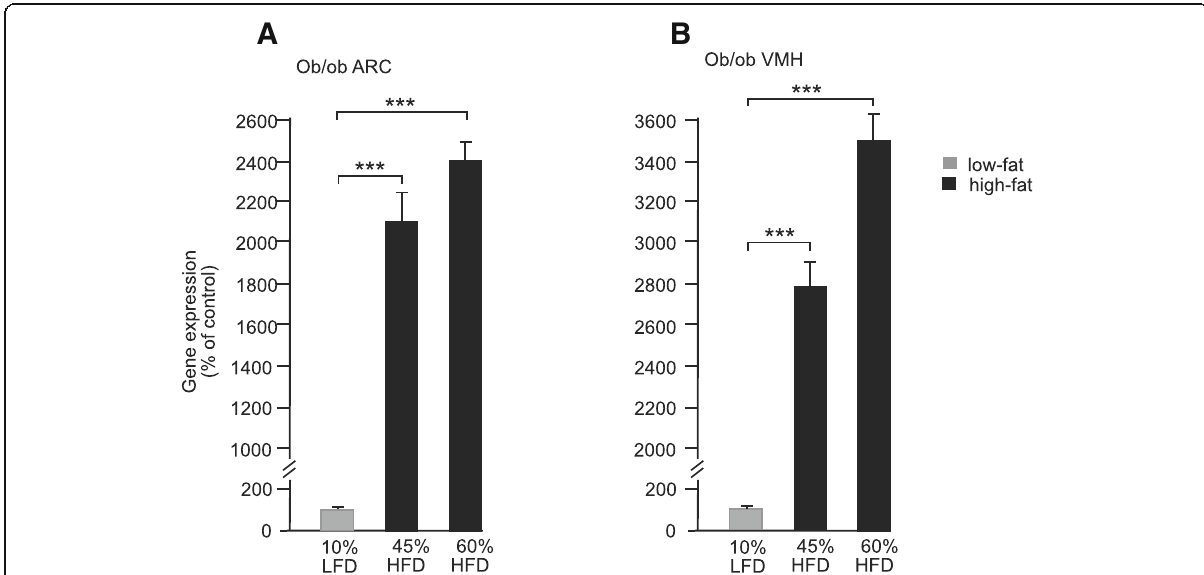
Fig. 5 Levels of serpinA3N gene expression measured by semi-quantitative in situ hybridisation in the a arcuate nuclei (ARC) and b ventromedial nuclei of the hypothalamus (VMH) of ob/ob mice fed either a LFD, 10% energy (kCal) from fat, or HFD either 45% or 60% energy (kCal) from fat for 8 weeks. *** P < 0.001 ( n = 6)